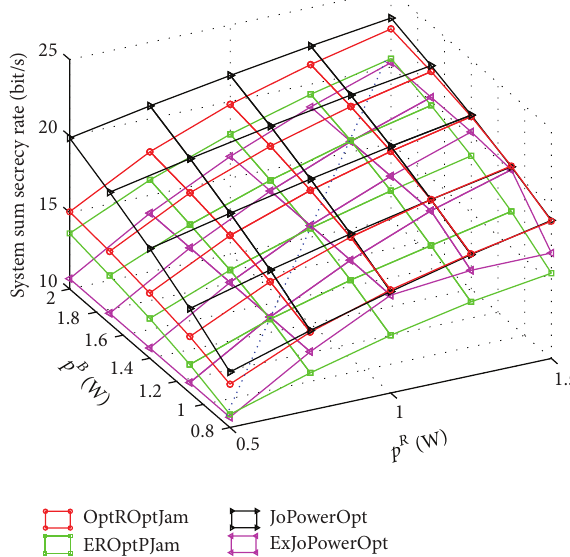
Figure 9: System sum secrecy rate versus UR and BS total